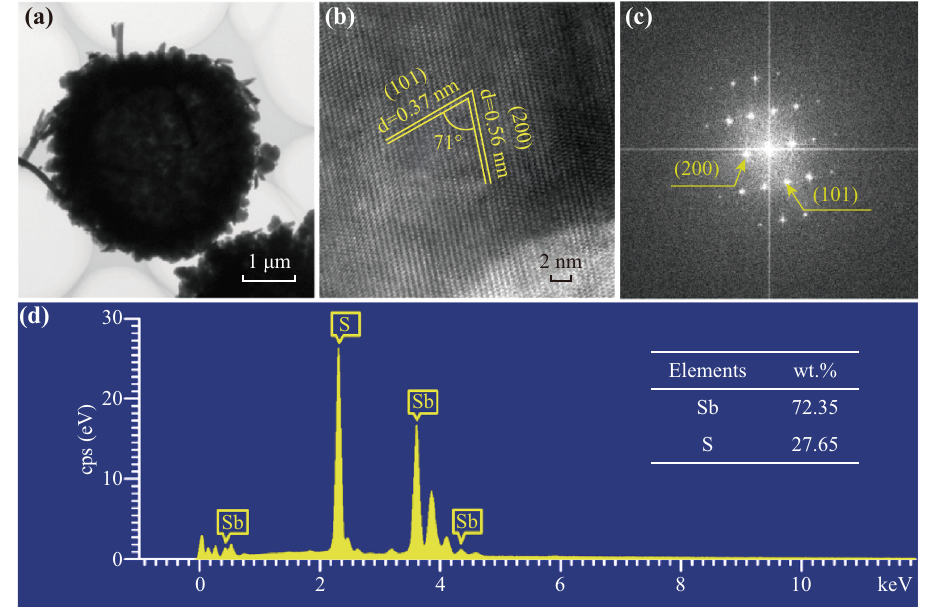
Fig. 3 a TEM image of random selected a particle of Sb 2 S 3 -150 sample. b HRTEM image of Sb 2 S 3 -150 sample taken from a . c FFT pattern of